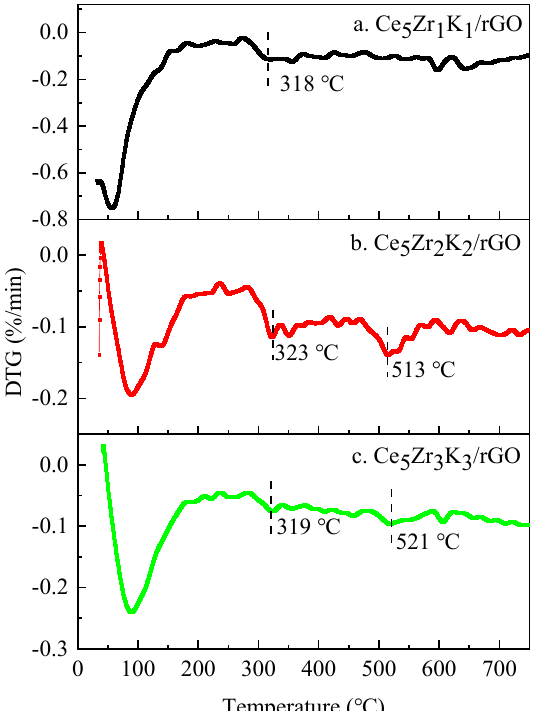
Figure 13. DTG plots of soot combustion in tight contact mode over CeZrK/rGO catalysts in a pure N 2 atmosphere.